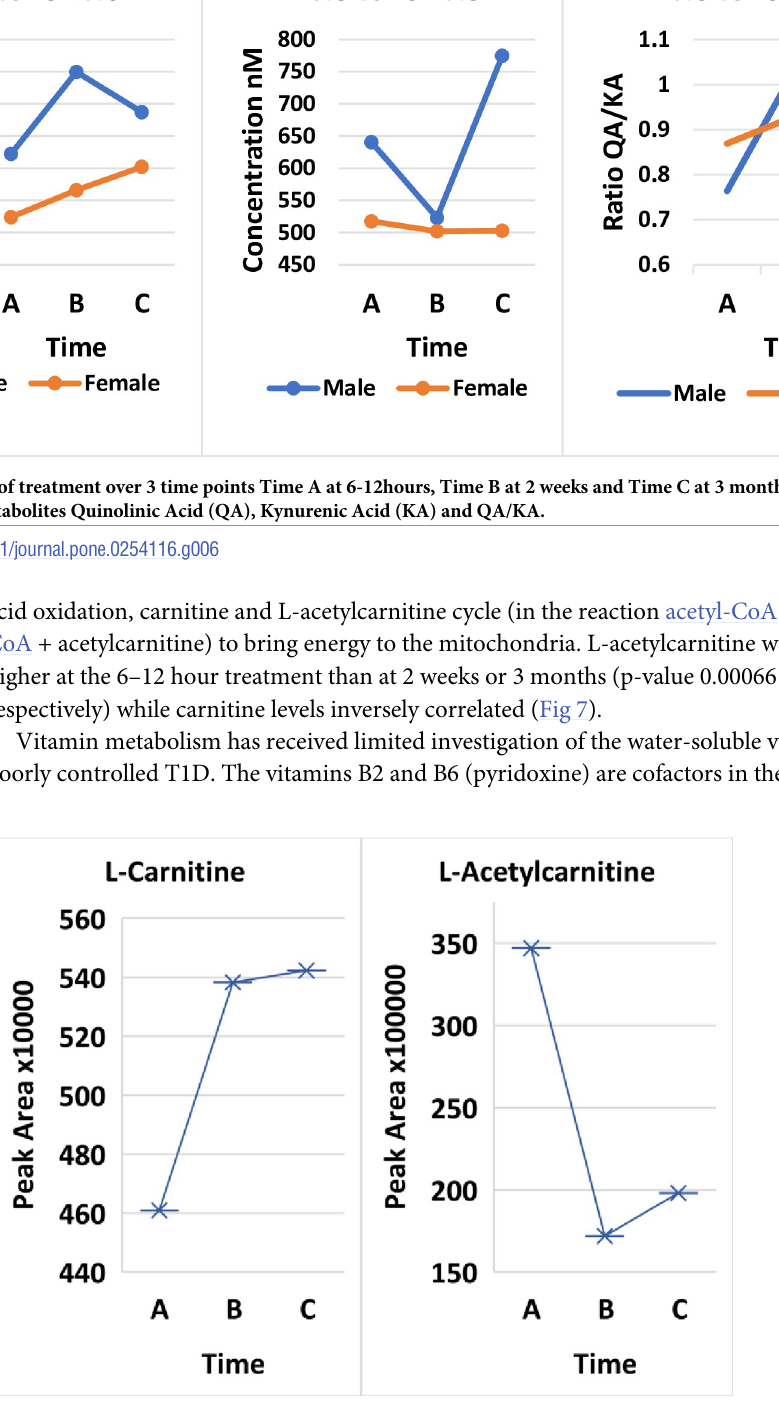
Fig 7. Comparison of treatment over 3 time points Time A at 6-12hours, Time B at 2 weeks and Time C at 3 months for L-carnitine and L-acetylcarnitine.